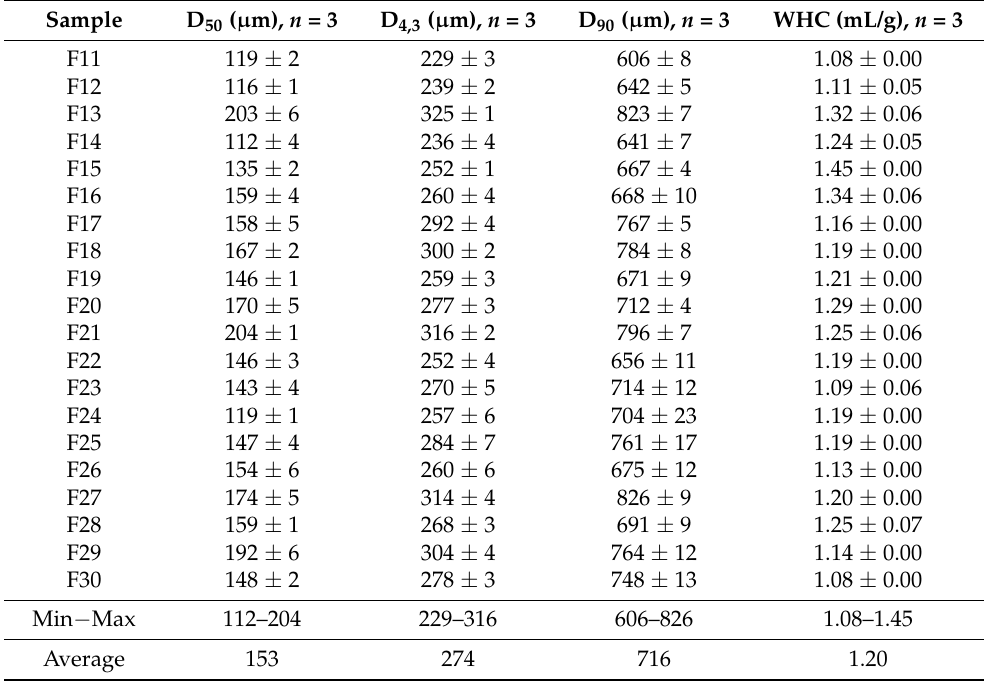
Table 1. The particle size distribution parameters (D 50 , D 4,3 , D 90 ) and centrifugal WHC of the oat flour samples ( n = 20) with the maximum, minimum, and average values of three replicate measurements. Error values represent standard errors of the means